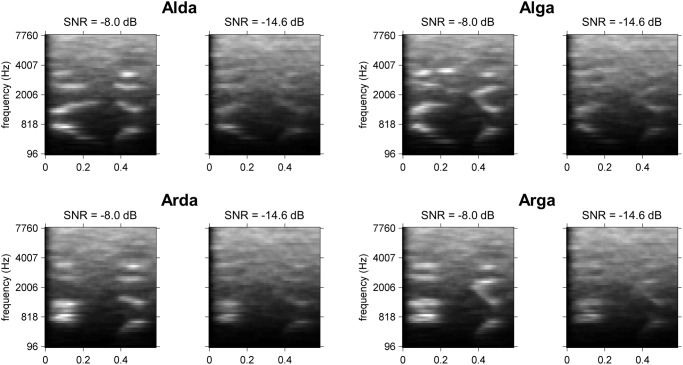
Cochleograms of the 4 signals in noise, with SNR = -8.0 dB or -14.6 dB.The parameters used for the cochleograms are described in paragraph Materials and Methods.